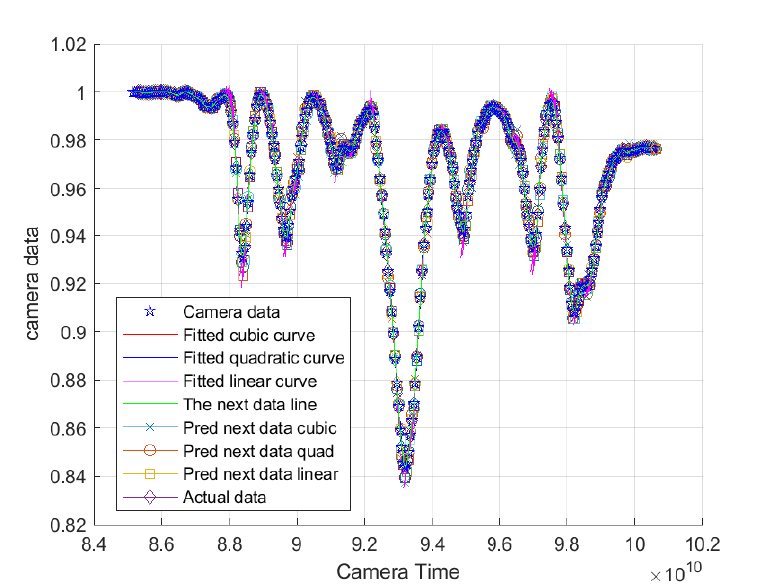
Figure 4. The fitted cubic, quadratic, and linear curves and the predicted next data for all camera data.